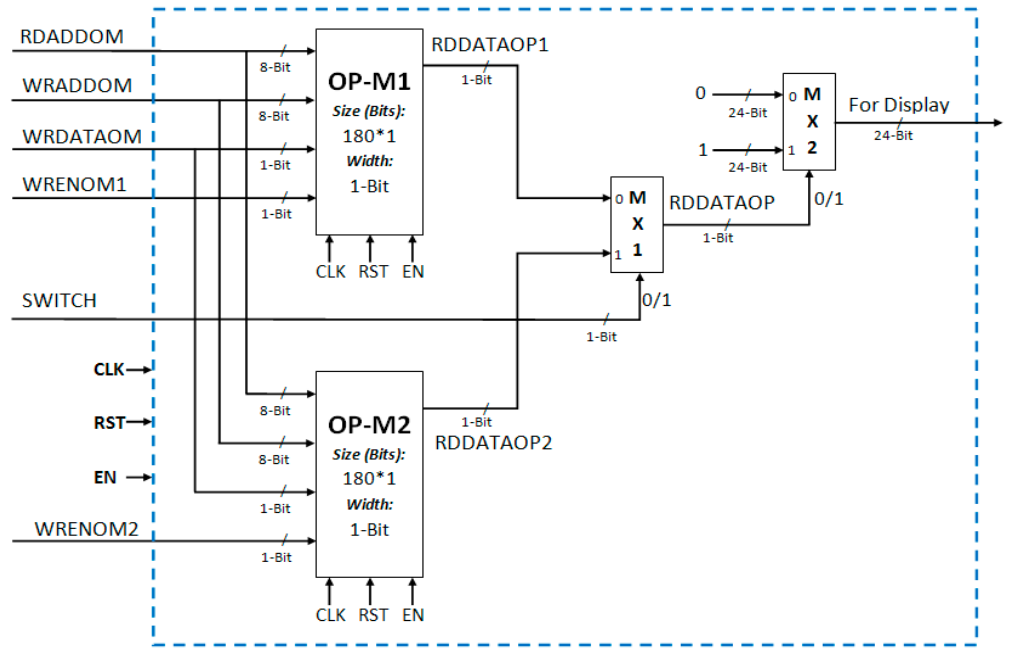
Figure 17. Proposed output buffer memory architecture.